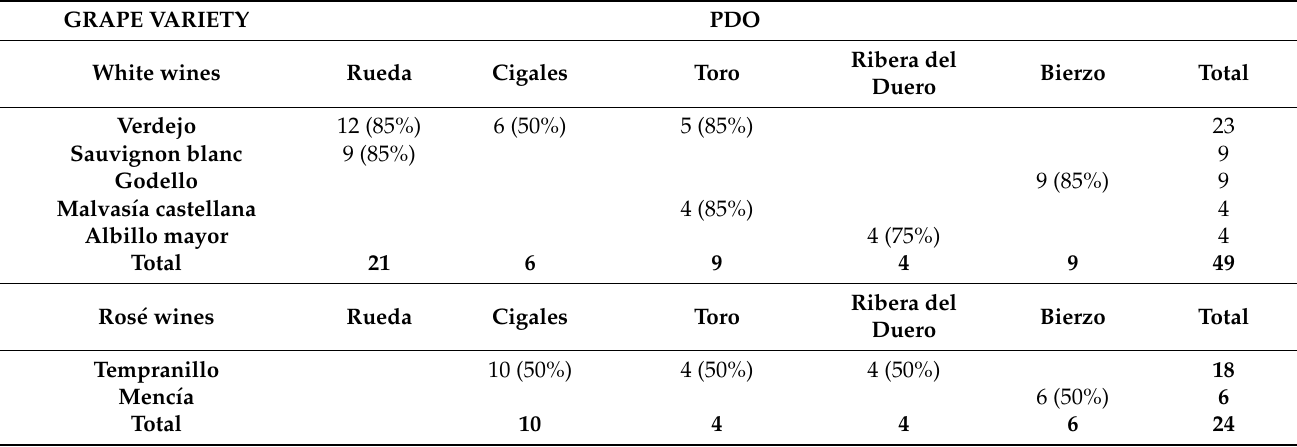
Table 1. Number of wines analyzed in the different PDOs and the minimum percentage of each variety (in parenthesis). GRAPE VARIETY PDO White